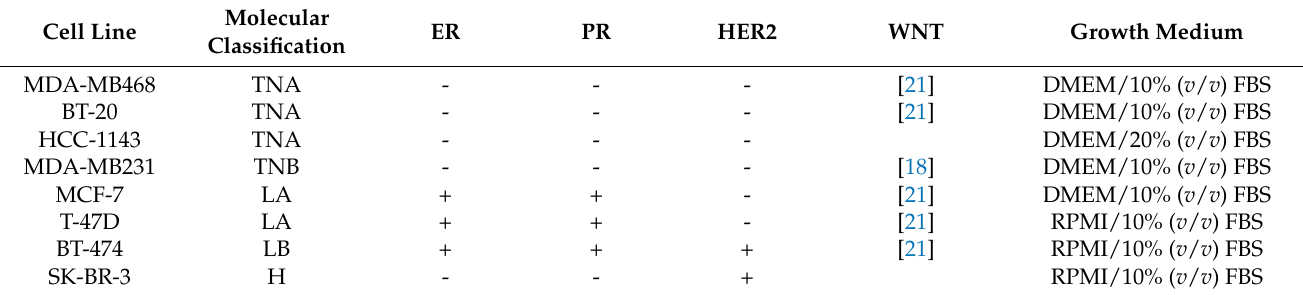
Table 1. Breast cancer cell lines used in the